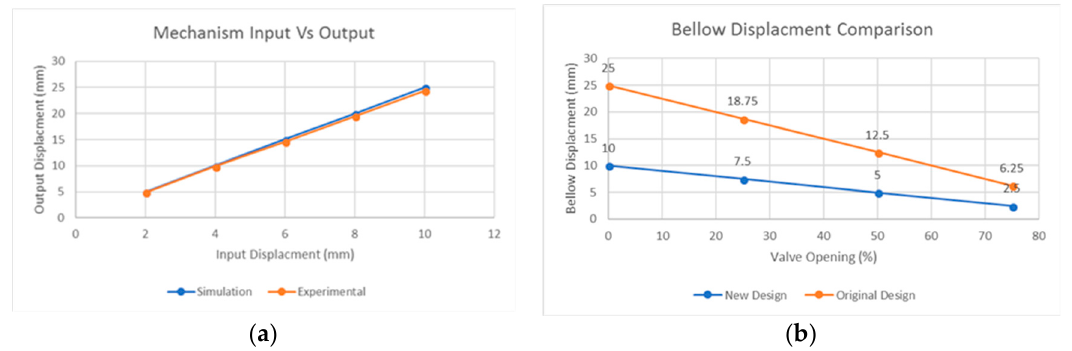
Figure 8. ( a ) Comparison of position analysis from the simulation and experiment. ( b ) Input displacement comparison of the original and new design.